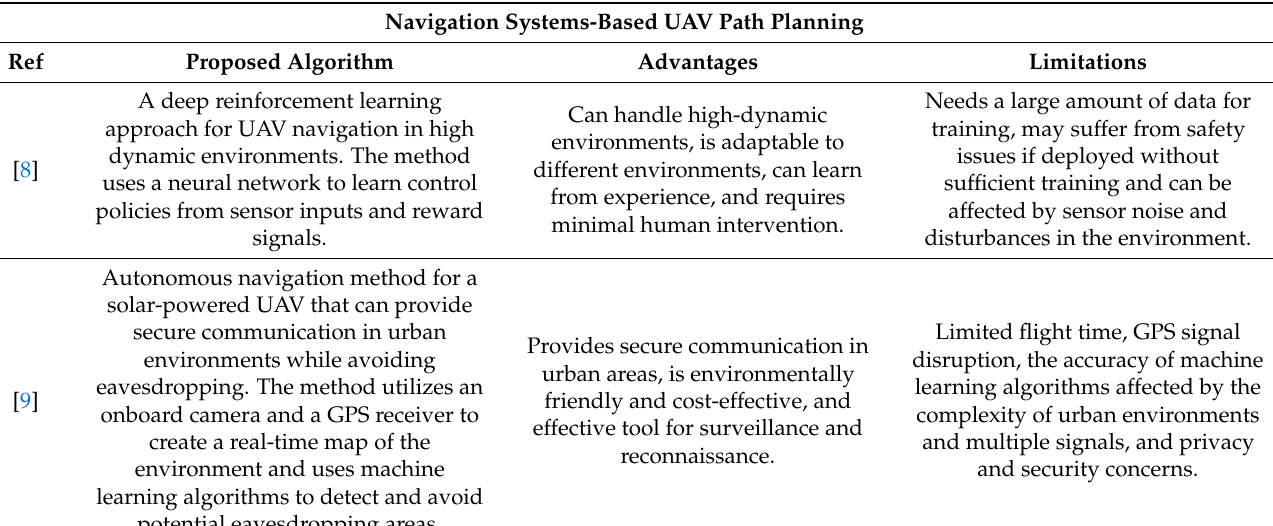
Table 1. A detailed study of UAV path planning using Navigation Systems-based UAV Path